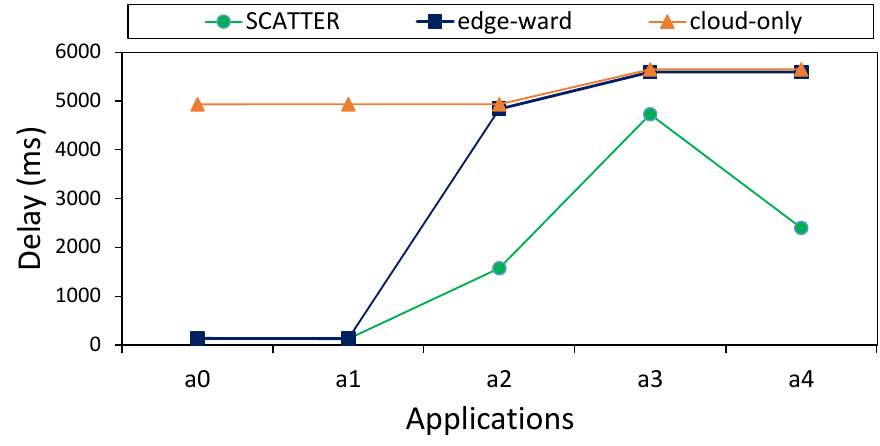
Figure 6. Average Applications Loop Delays.